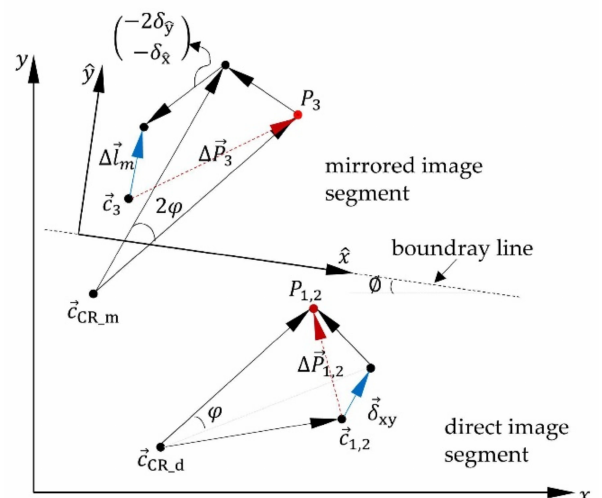
Figure 4. Crosstalk behavior in both in- and out-of-plane displacement and the possibility of deter- mining the causing